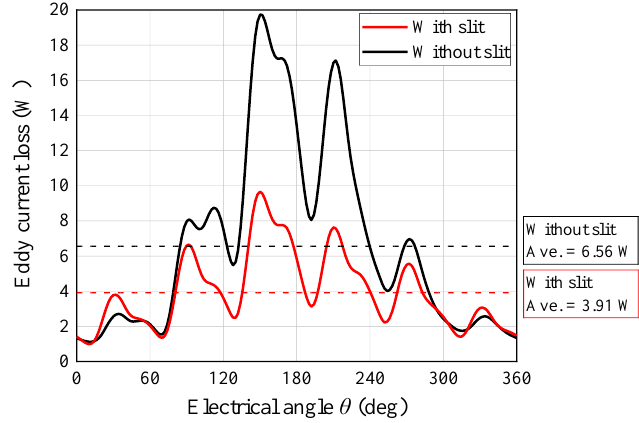
Figure 10. Eddy current loss of stator frame with q -axis current of 80 A.